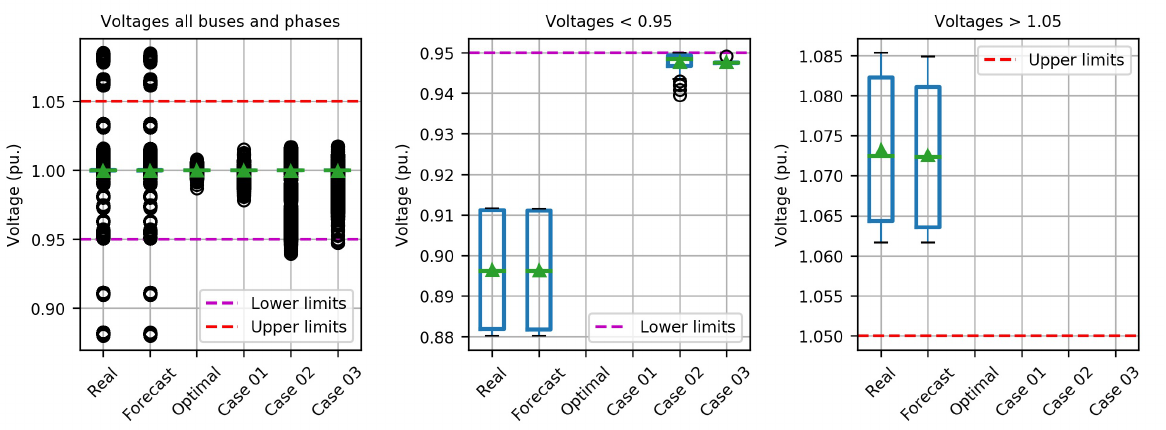
Figure 6. Voltage magnitude distributions for benchmarks, optimal and three cases with under and over voltages for each of the